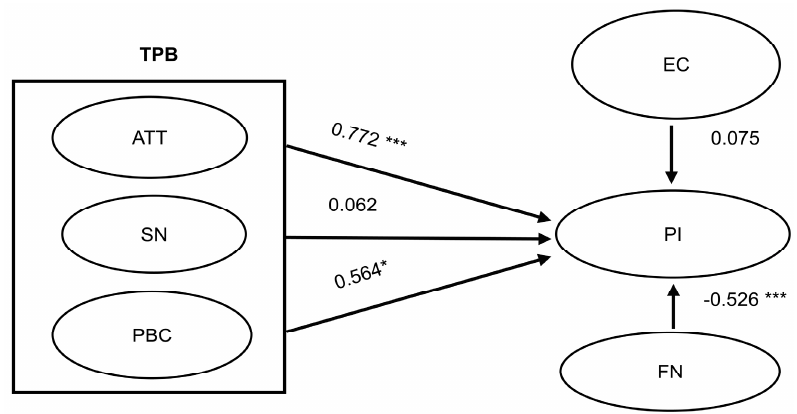
Figure 2. Results of structural equation modeling. * p < 0.05; *** p < 0.001; GFI = 0.908; AGFI = 0.873; CFI = 0.932; TLI = 0.733; RMSEA = 0.069.